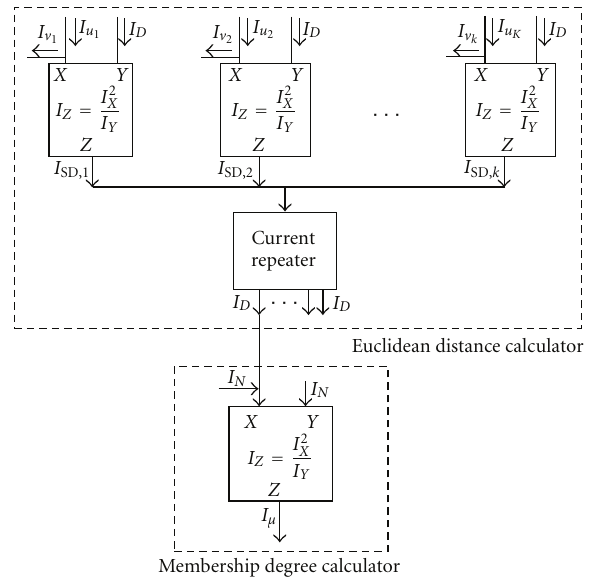
Figure 1: Block diagram of the proposed current-mode fuzzy